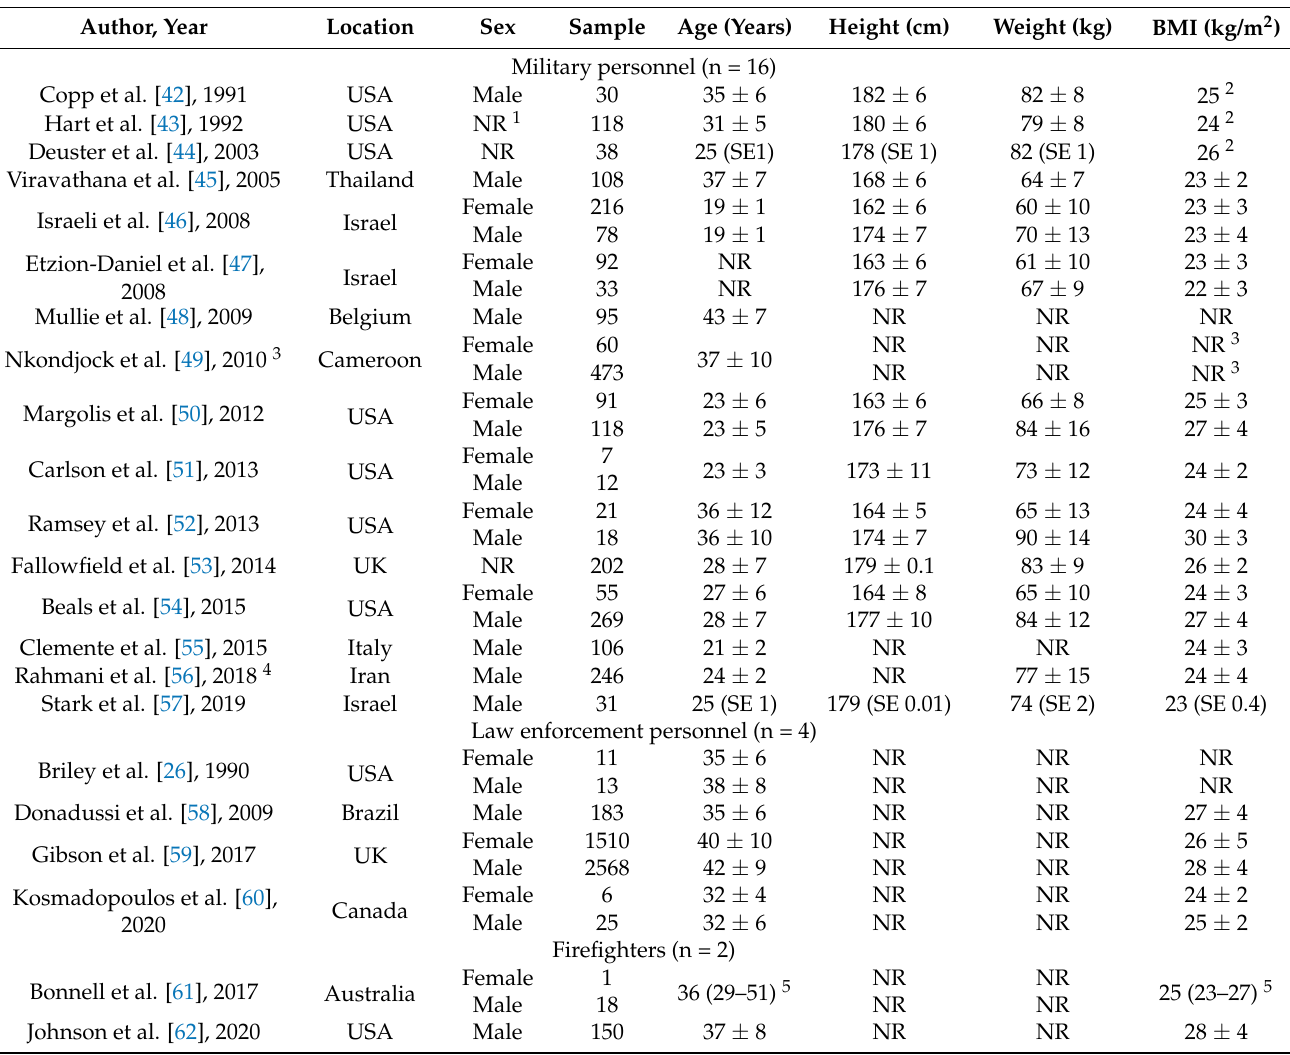
Table 2. Study and sample characteristics of included studies (N = 22; Mean ±